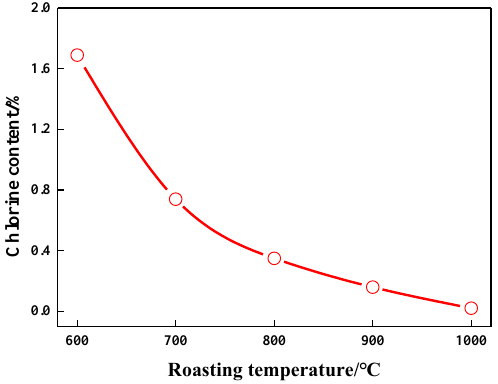
Figure 4. Effect of roasting temperature on chlorine content of zinc ash.